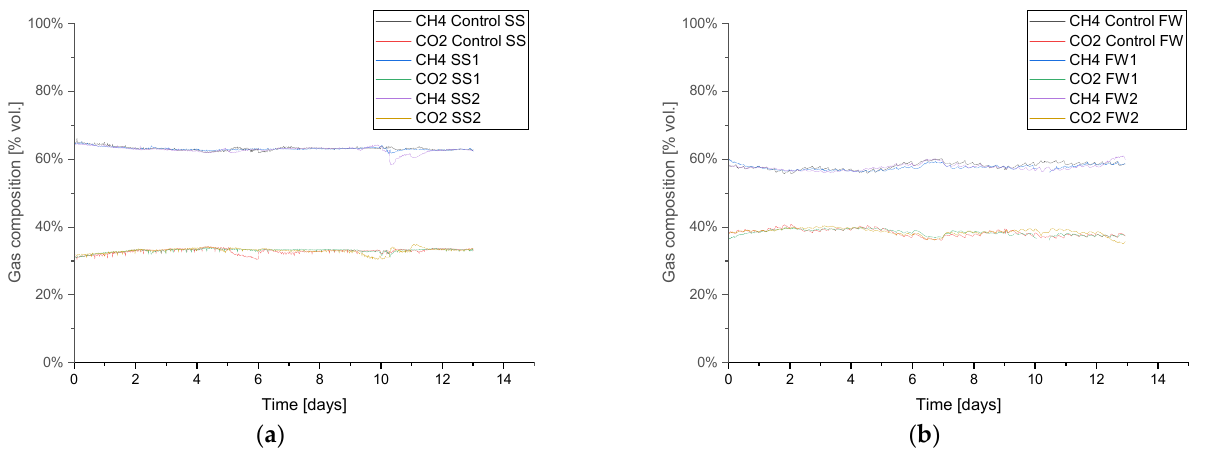
Figure 5. Biogas composition profile during a baseline AD testing prior to hydrogen injection, for sewage sludge (SS) ( a ) and food waste (FW) ( b ).